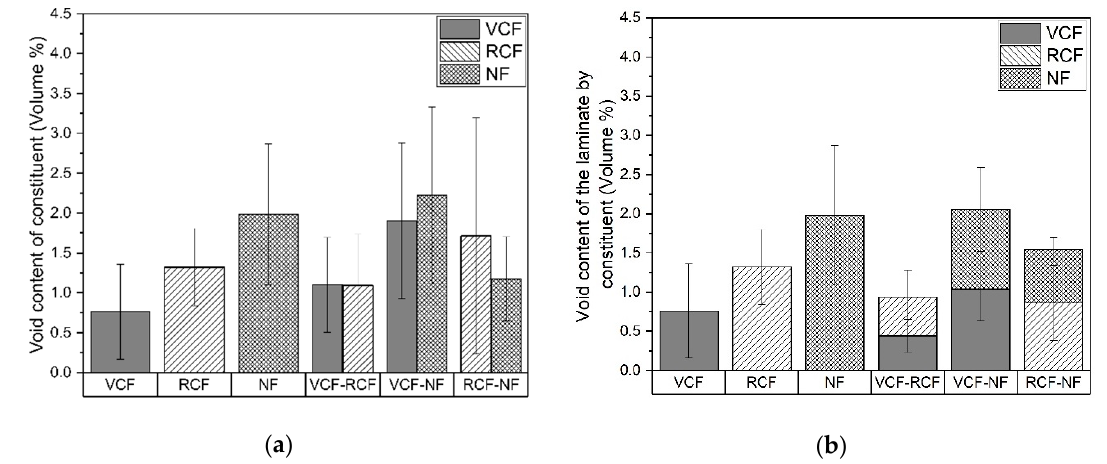
Figure 7. ( a ) Void content of each laminate with respect to the void content of its constituent layers. ( b ) Void content of each laminate as a proportion of its constituent layers.